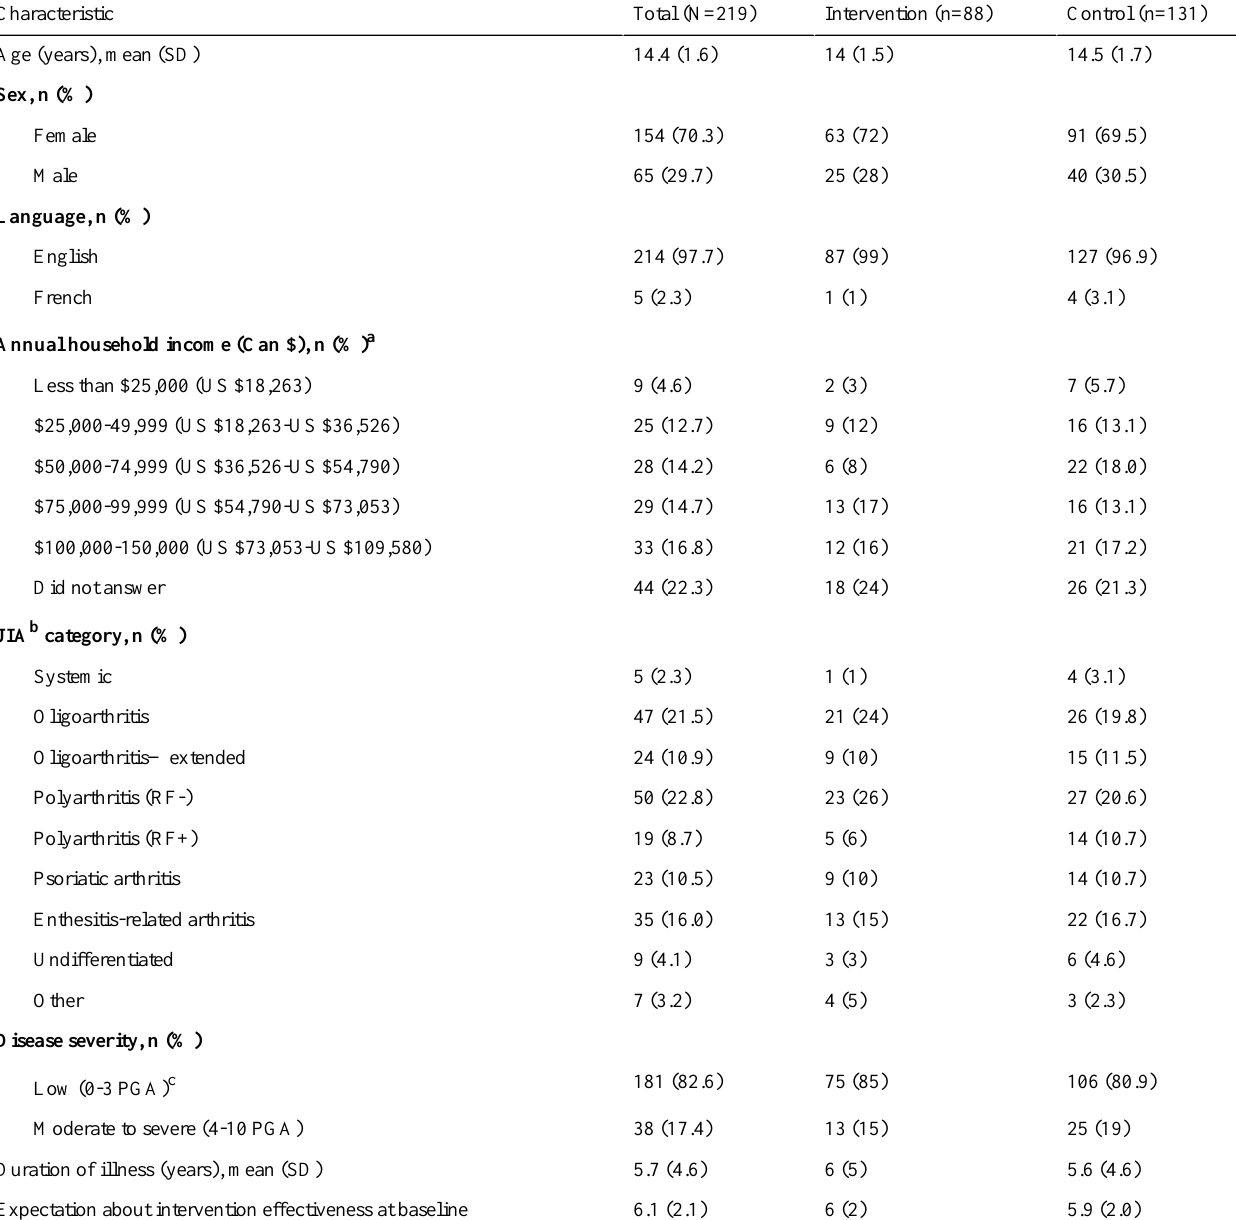
Table 2. Adolescent demographic and disease